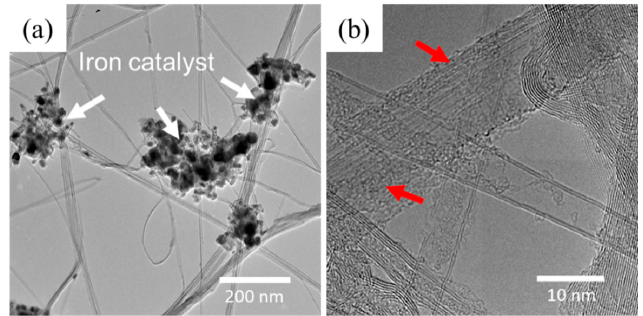
Figure 3. Raman spectrum of CNT sheet with G, D and D’ peaks. Figure 2. Transmission electron microscopy (TEM) characterization of carbon nanotubes (CNT). ( a ) Low magnitude image showing agglomeration of iron catalyst nanoparticles (highlighted by white arrows). ( b ) high magnitude image showing individual nanotubes covered by amorphous carbon (red arrows).